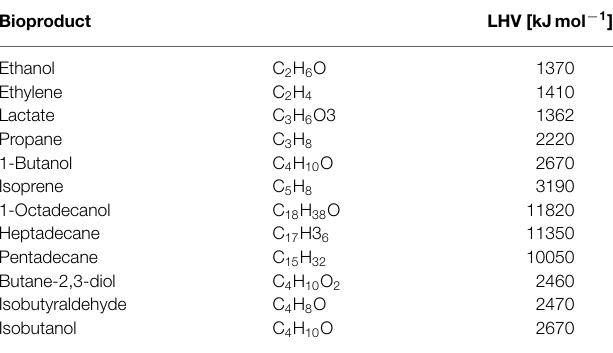
TABLE 3 | Elemental stoichiometry and lower heating value (LHV) for selected cyanobacterial bioproducts .